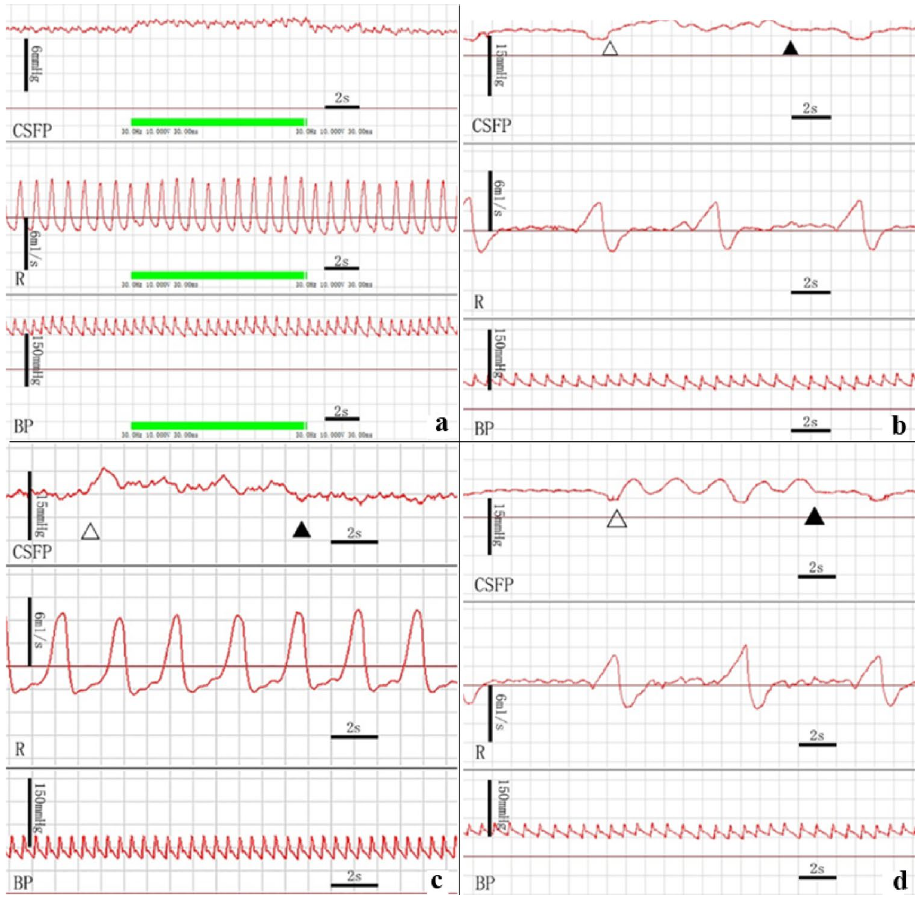
Figure 6. Measurements of CSF pressure during electrical stimulation of the suboccipital muscles or during passive head movements. The CSF pressure was significantly increased when the OCI muscle was stimulated but no change occurred in the blood pressure and respiration rate (Fig. 6a). And a rise and waveform change of CSFP appeared during the lateral head flexion (Fig. 6b), head rotation (Fig. 6c), and head flexion and extension (Fig. 6d), without changes in the respiration and blood pressure. CSFP: Cerebrospinal fluid pressure, R: Respiration, BP: Blood pressure, Hollow Triangle: the beginning of passive motion of the head, Filled Triangle: the end of passive motion of the head.